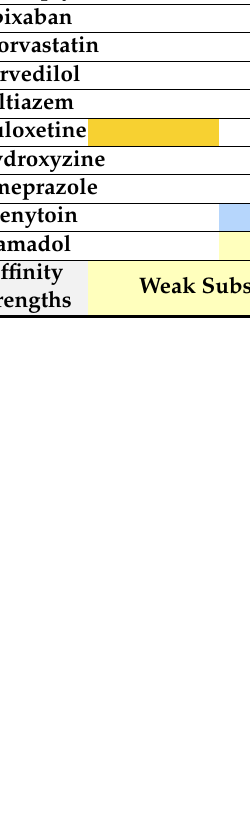
Table 4. Pharmacist’s recommendations and implementations during medication safety